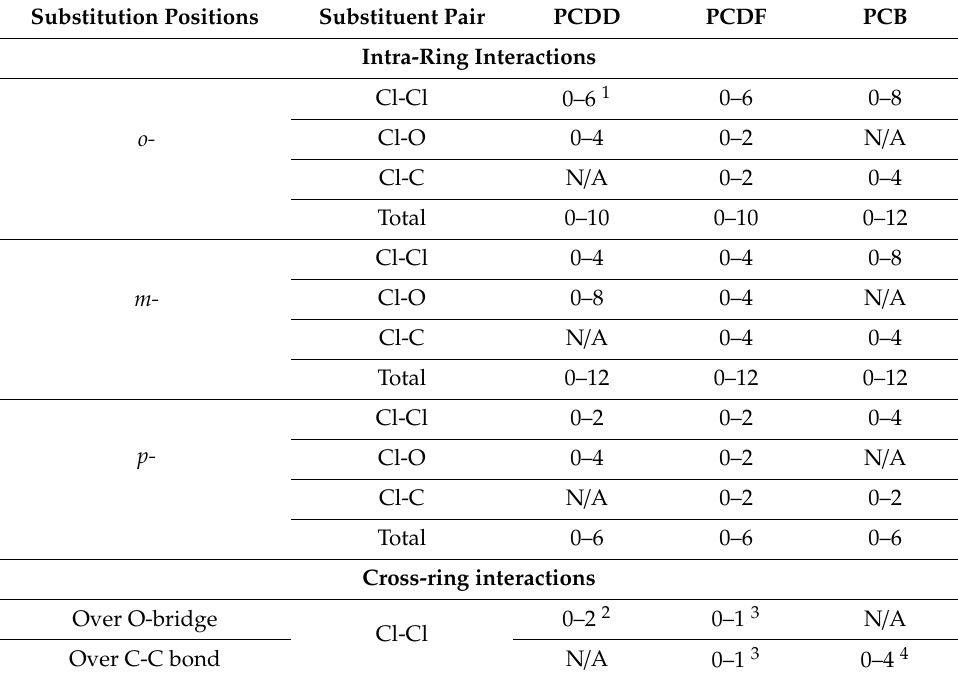
Table 1. Possible numbers of substituent pairs for each